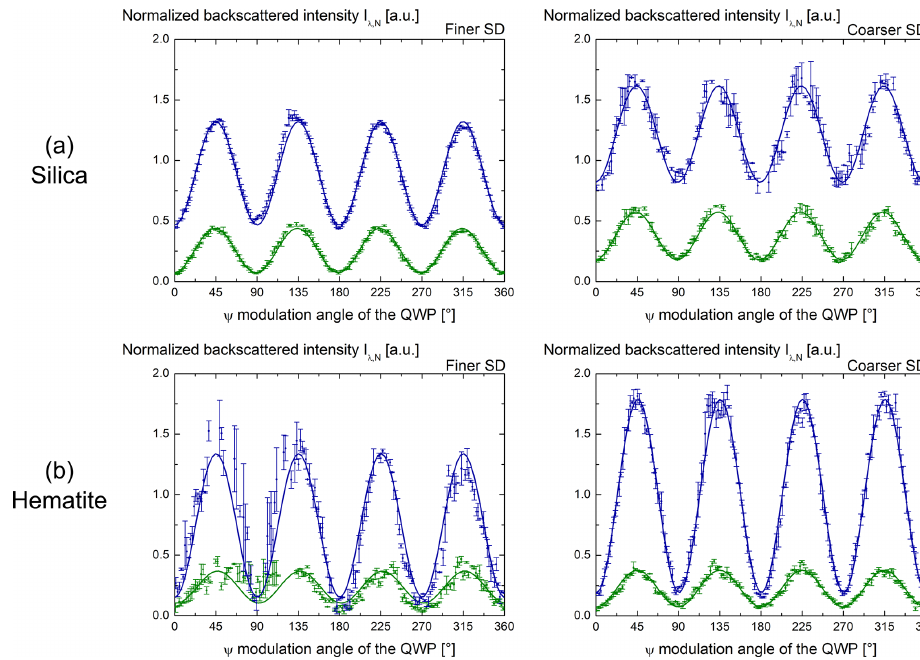
Figure 5. The same as Fig. 4 for silica (a) and hematite samples (b) . Table 2. The same as Table 1 for silica and hematite. Bold values are used to emphasize the presented